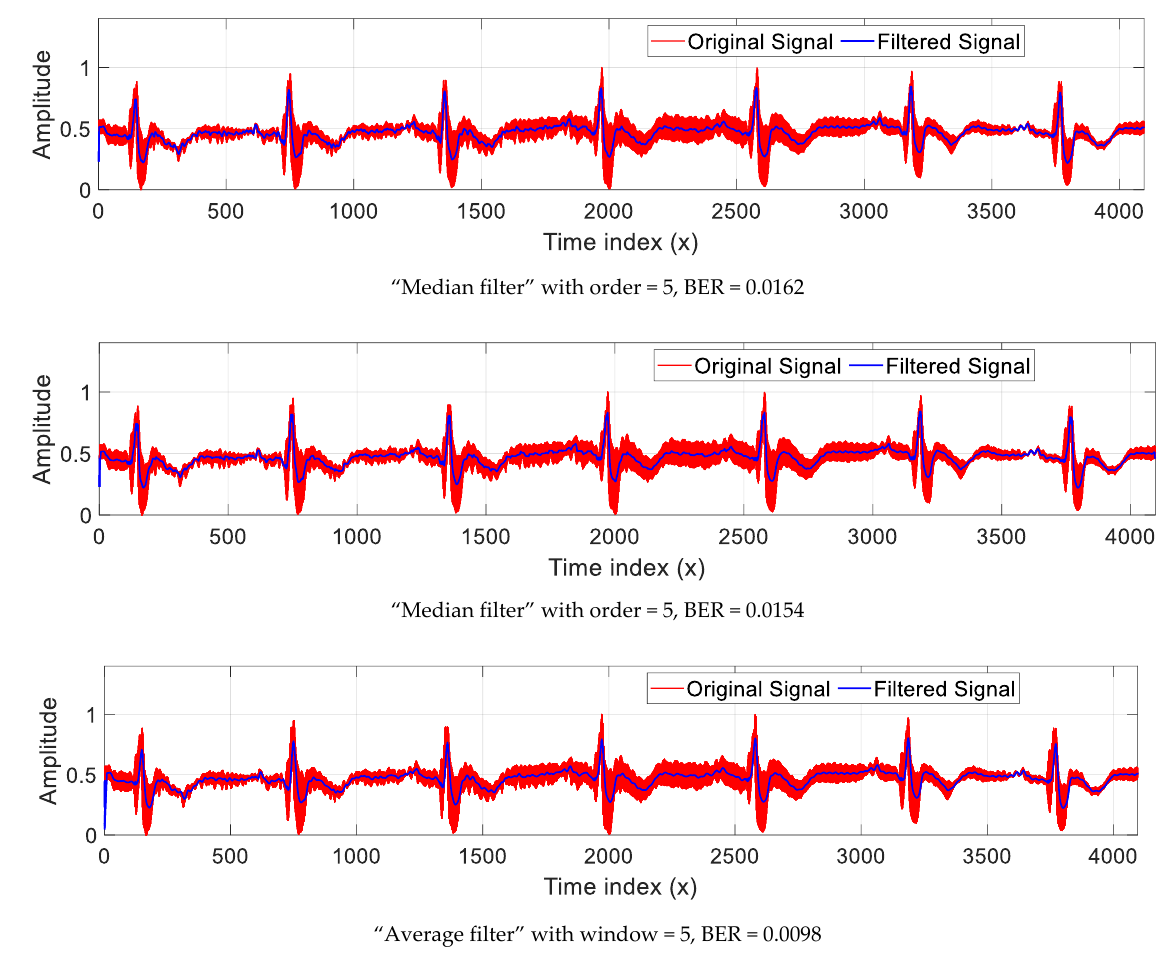
Figure 20. Original ECG signal and its filtered versions with the corresponding BER values .